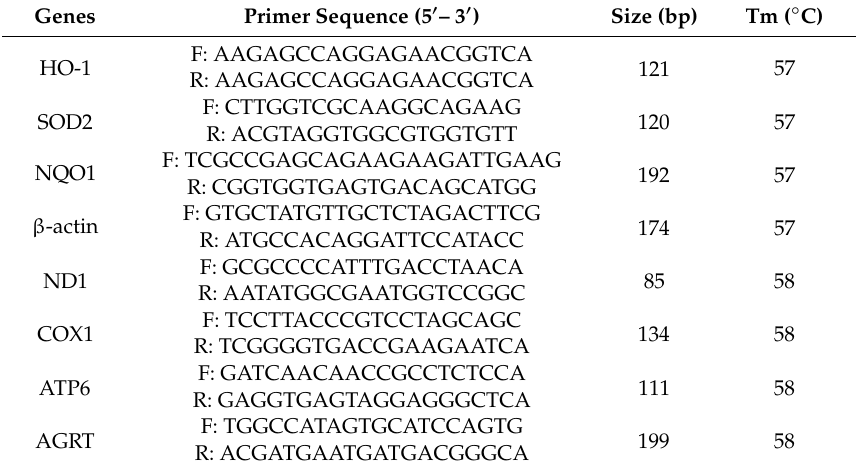
Table 2. Primer sequences used in the present